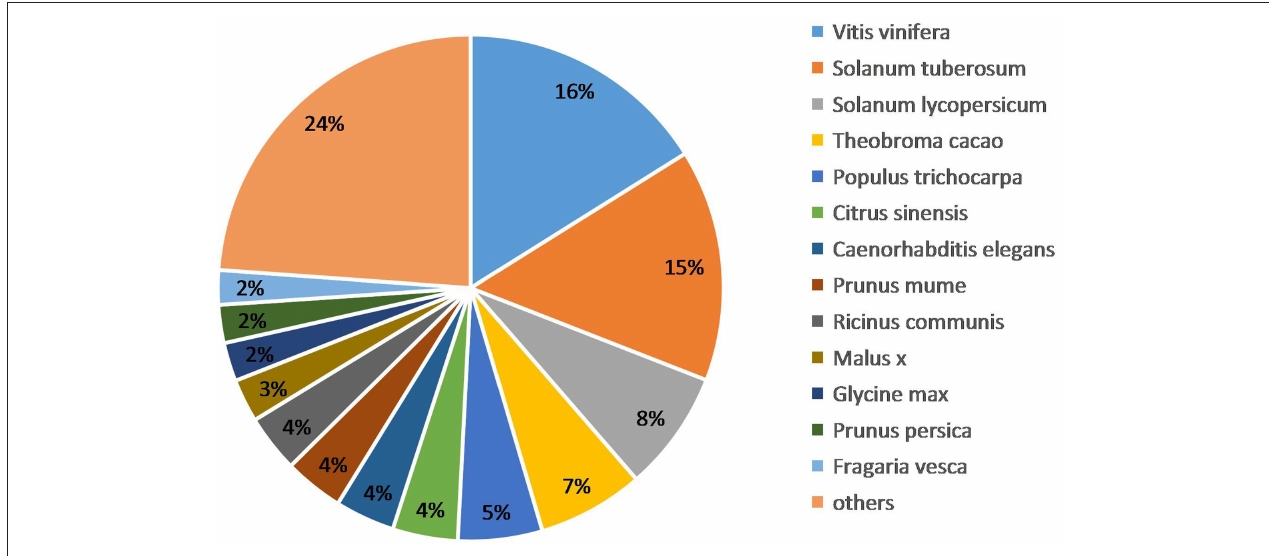
FIGURE 3 | Species homology analysis of the Nt